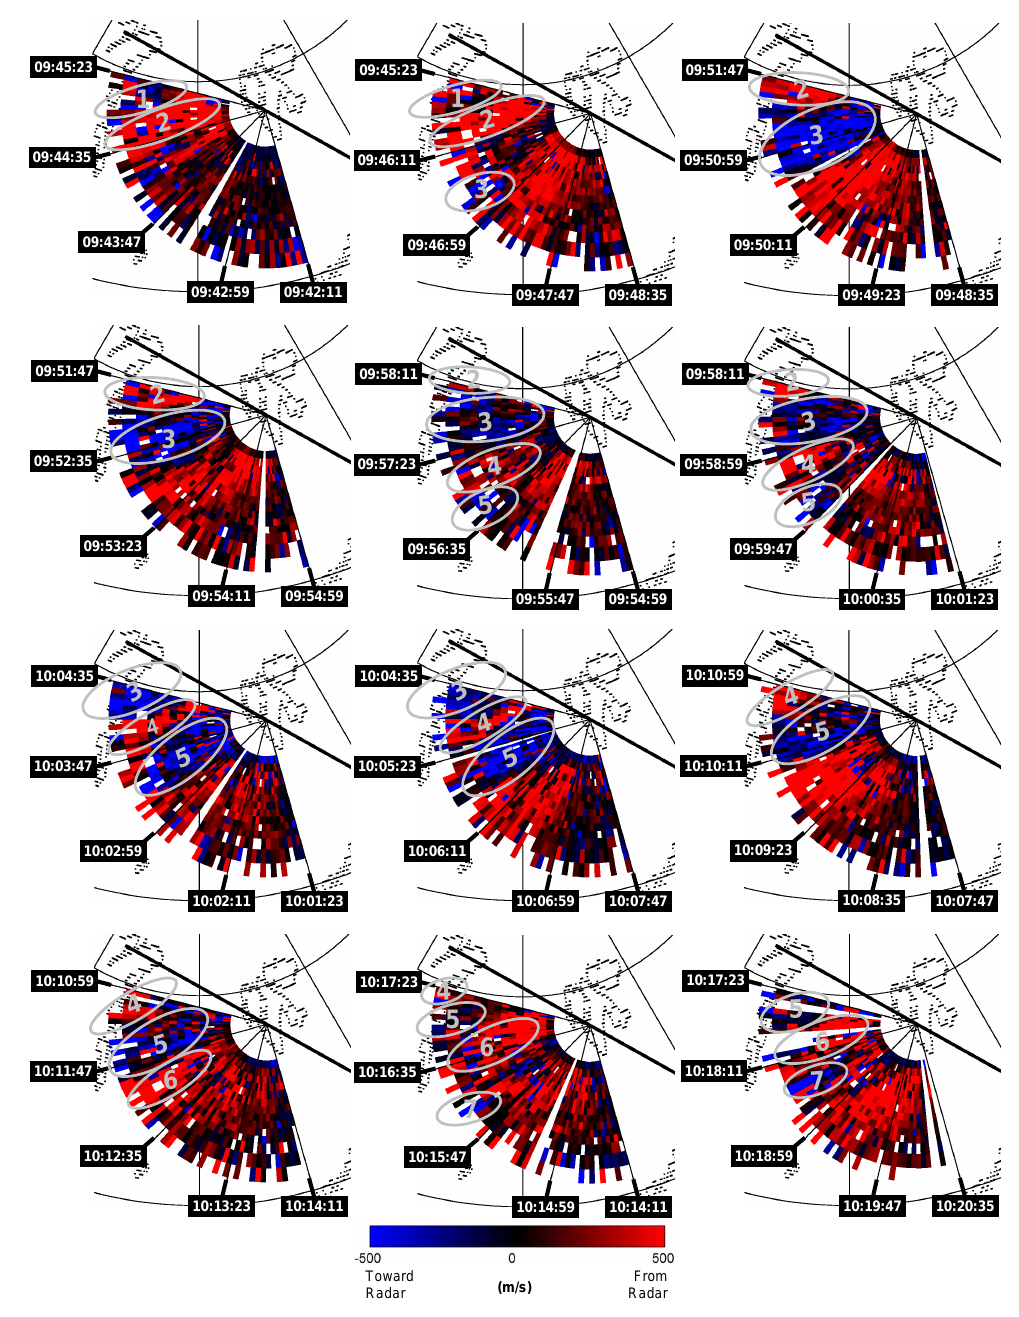
Fig. 3. Ion flow observations from a sequence of fast windshield wiper scans of the EISCAT Svalbard Radar. The radar was scanning back and forth in azimuth to the west of Svalbard, and shown with colors is the radar line-of-sight plasma flow, where red corresponds to drift away from the radar and blue is towards the radar. Identified with numbers are seven flow channels, see text for details.